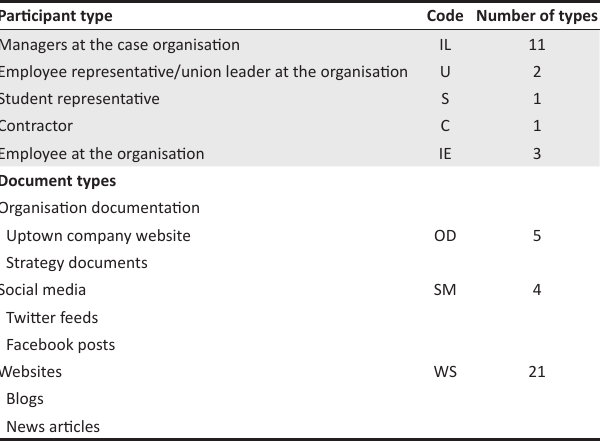
TABLE 1: Participant codes.